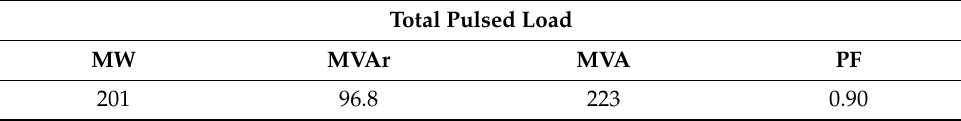
Table 5. Total active, reactive and apparent power required by PPED distribution subsystem of